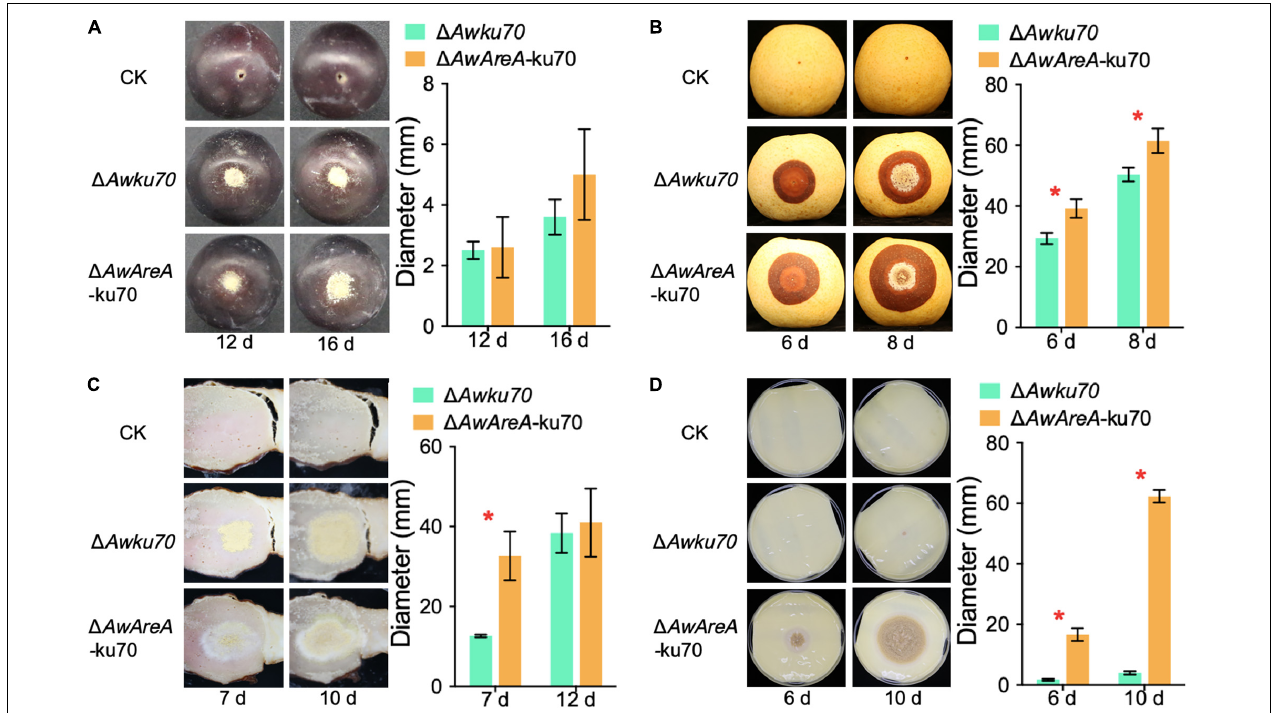
FIGURE 7 | Pathogenicity assay of (cid:49) Awku70 and (cid:49) AwAreA -ku70 of Aspergillus westerdijkiae on grape (A) , pear (B) , salted meat (C) , and cheese (D) . The red asterisk in the histogram indicates a significant difference between the corresponding values ( p < 0.01) with three biological